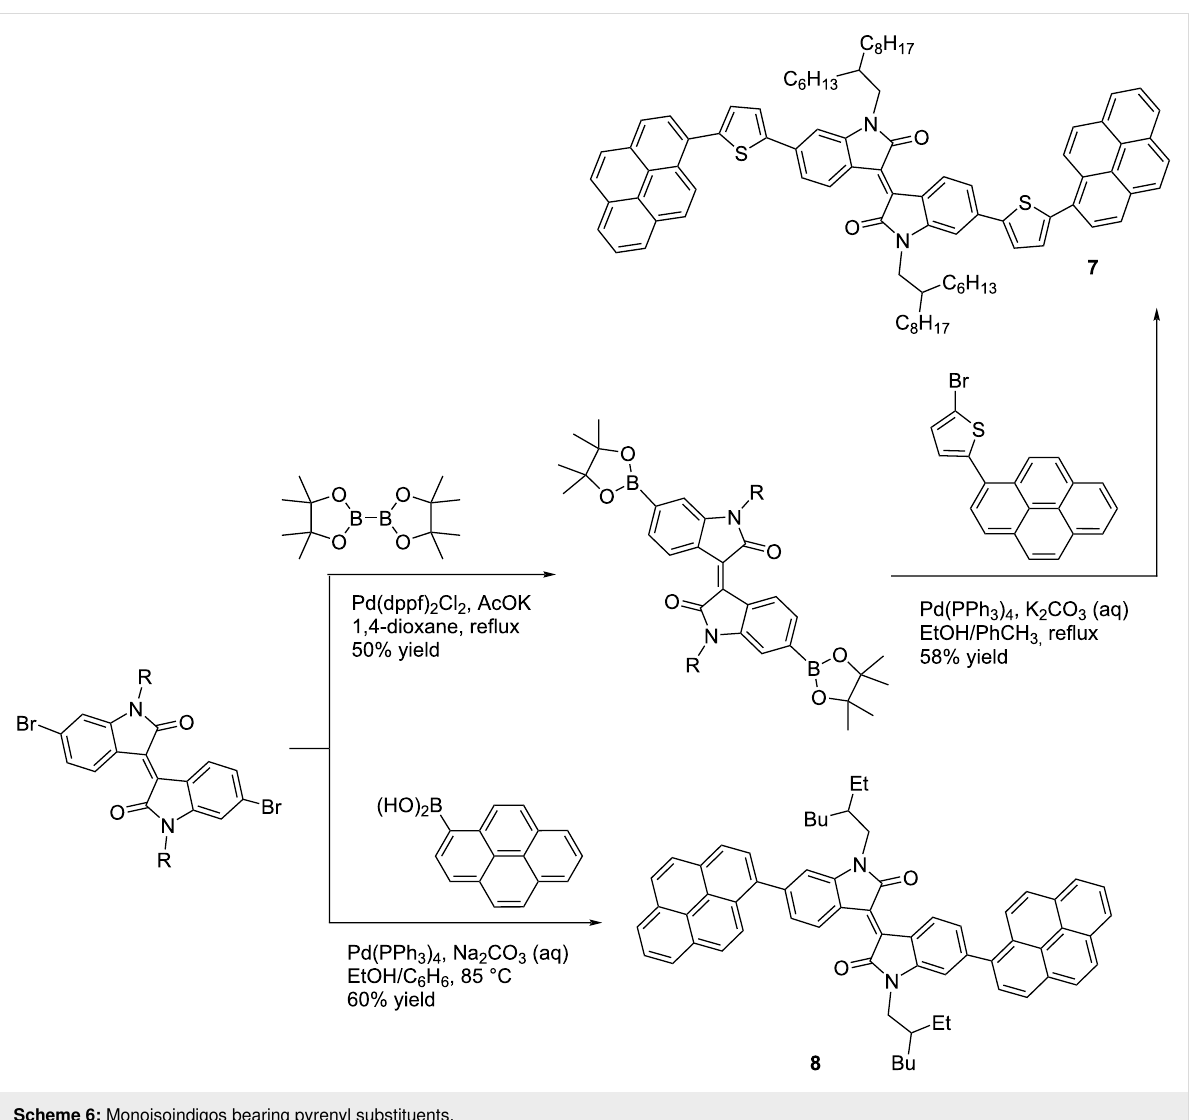
Scheme 6: Monoisoindigos bearing pyrenyl